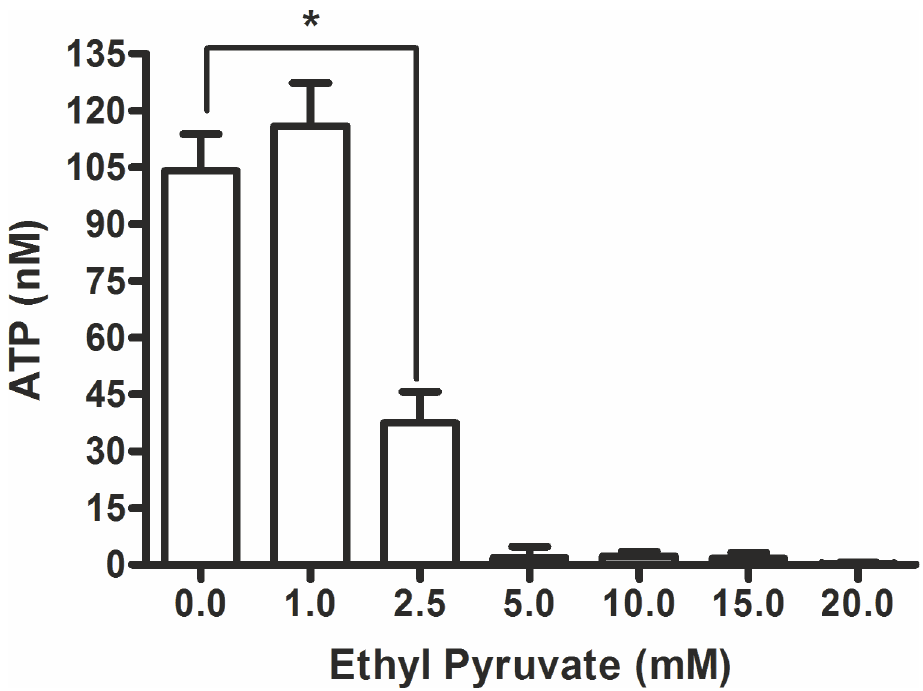
Fig 4. Effect of ethyl pyruvate at cellular ATP level in T . brucei . Trypanomomes (3x10 5 cells/well) were cultured in 24-well plates in the absence (control) or presence of ethyl pyruvate (1 to 20 mM) and incubated for 3 hrs at 37°C in 5% CO 2. After incubation, cells were centrifuged at 1500 rpm for 10 min and supernatant was removed. The cell sediment was re-suspended smoothly in 500 μ l of fresh medium. From this suspension 50 μ l (equivalent to 3x10 4 cells) was added into a 96-well black opaque-walled plate in duplicates and mixed with 50 μ l of test reagent per well. Luminescence was read at 560 nm. The actual ATP level was calculated from the trend line formula of the standard curve (n = 3), * p <